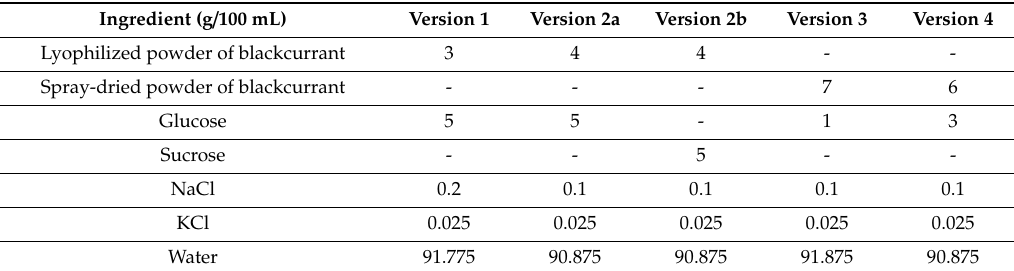
Table 1. Recipe compositions of designed